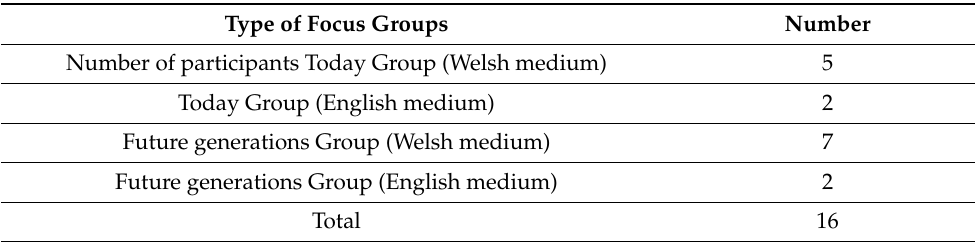
Table 1. Number of participants within each focus